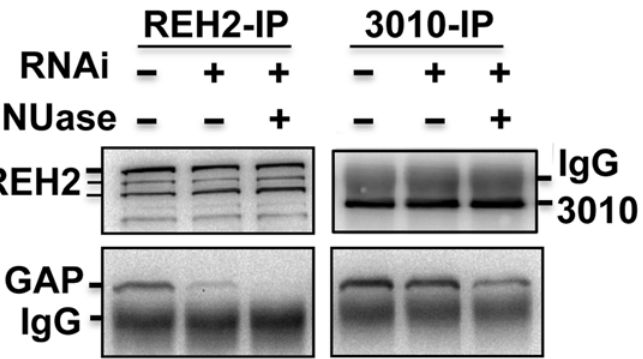
nuclease. Untreated mitochondrial extract was used as a control.